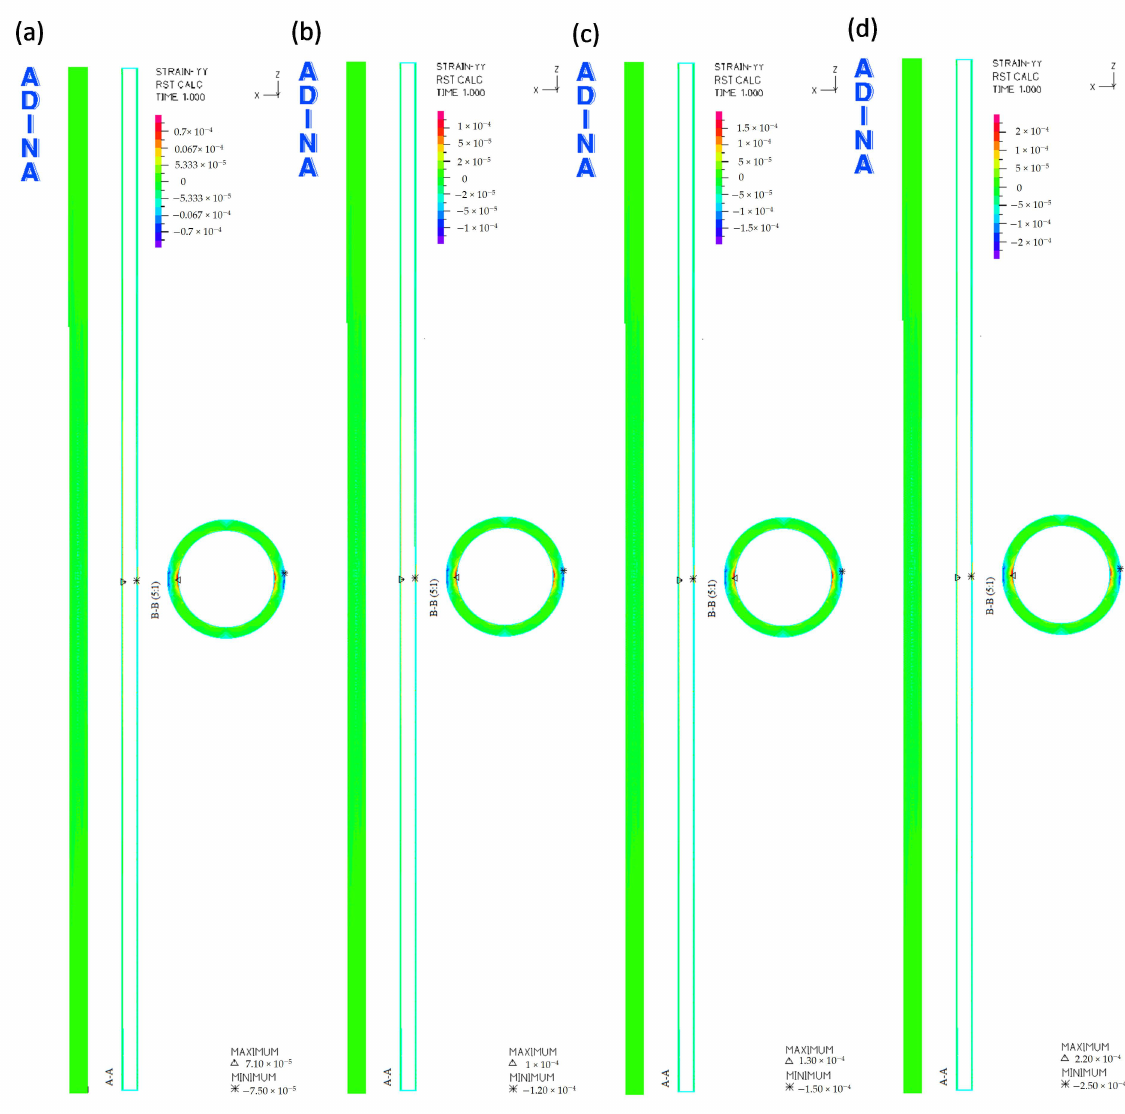
Figure 8. The pipe transverse deformations ε y at the following loads: ( a ) 500 N, ( b ) 1000 N, ( c ) 1500 N, ( d ) 2000